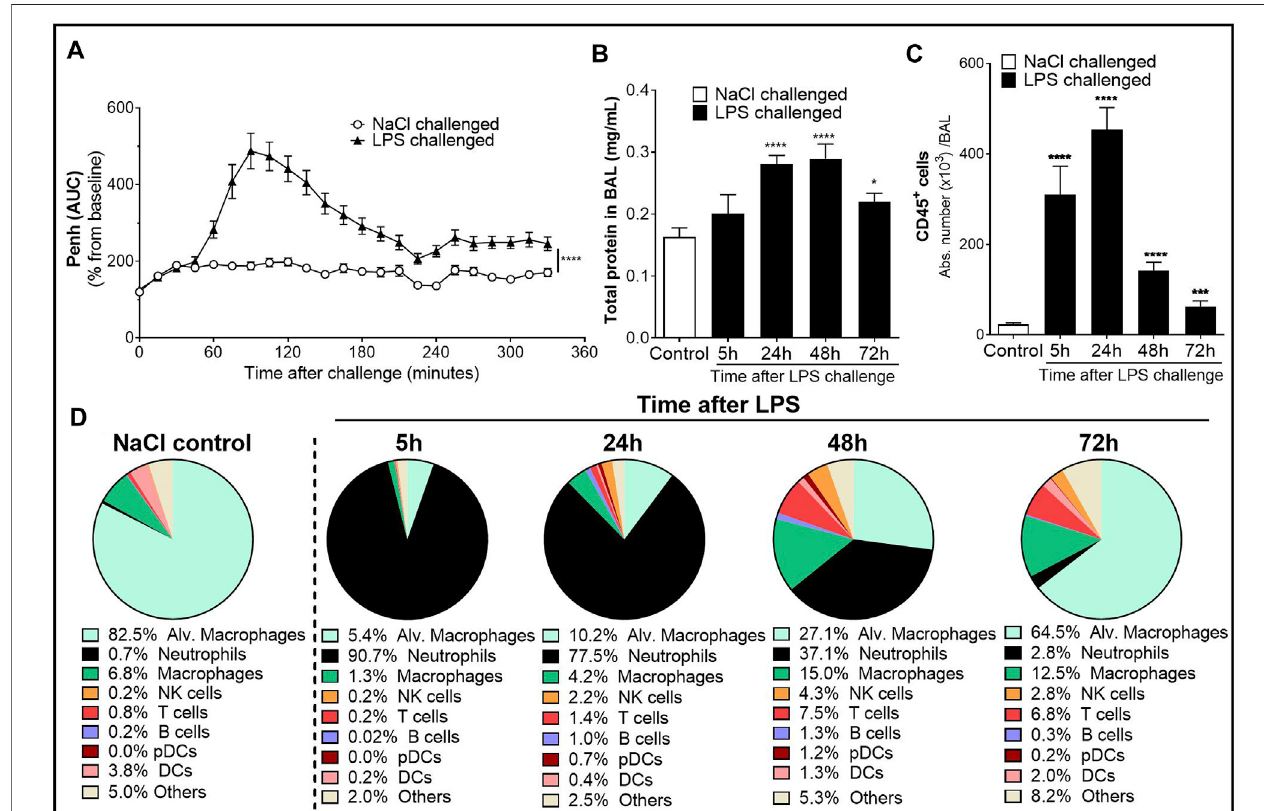
FIGURE 1 | Characterization of the lipopolysaccharide (LPS)-induced acute lung injury (ALI)/acute respiratory distress syndrome (ARDS) model in male DBA/1 mice.LPSinhalationwasassociatedwithasigni fi cantbreathingpatternalteration (A) ,anincreaseinalveolar – capillarybarrierpermeability (B) ,andincreasedimmunecell in fi ltrates in the bronchoalveolar space (C, D) compared with NaCl-exposed mice (control mice). (A) Breathing pattern alteration was measured by the change in the calculated enhanced pause (Penh) using whole-body plethysmography in conscious unrestrained mice over a period of 6 h following LPS (black triangles) or NaCl inhalation (white circles). Results are expressed as the mean percentage Penh area under the curve (AUC) normalized to the baseline ± SEM ( n (cid:1) 16 mice per group). **** p < 0.0001 paired Student t -test. (B) Alveolar – capillary barrier permeability was assessed by measuring the total protein concentration in the bronchoalveolar lavage (BAL) supernatant at 5, 24, 48, and 72 h after LPS challenge (black bars, n (cid:1) 7 – 16 mice per time point) or NaCl challenge (control mice, white bar, n (cid:1) 20; all time points were pooled). Results are expressed as mean ± SEM. * p < 0.05, **** p < 0.0001 paired Student t -test. (C) Time course of CD45 + immune cells in the BAL measured by fl ow cytometry in samples collected at 5, 24, 48, and 72 h after LPS challenge (black bars, n (cid:1) 7 – 16 mice per time point) or NaCl challenge (control mice, white bar, n (cid:1) 20; all time points were pooled). Results are expressed as mean ± SEM. *** p < 0.001, **** p < 0.0001 paired Student t -test. (D) Frequencies of BAL immune cell populations over time. Results are expressed as proportions among total CD45 + cells for each time